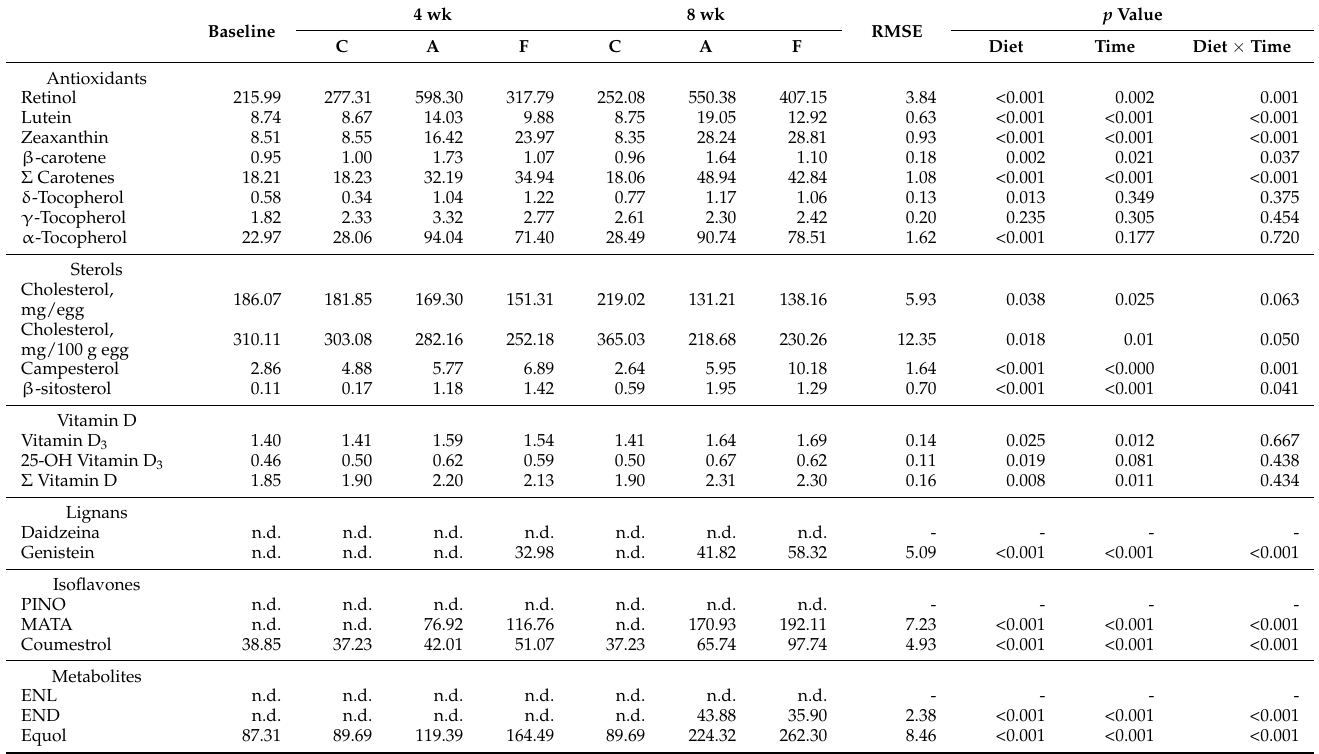
Table 3. Antioxidants (mg/100 g egg f.m.), sterols (mg/100 g egg f.m.), vitamin D ( µ g/100 g